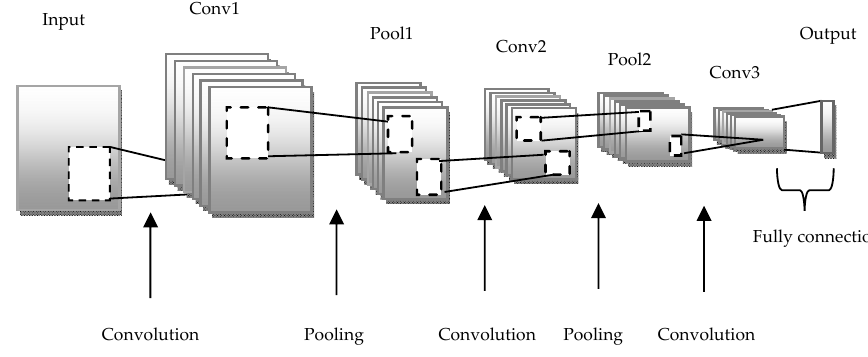
Figure 4. The proposed convolution network structure.